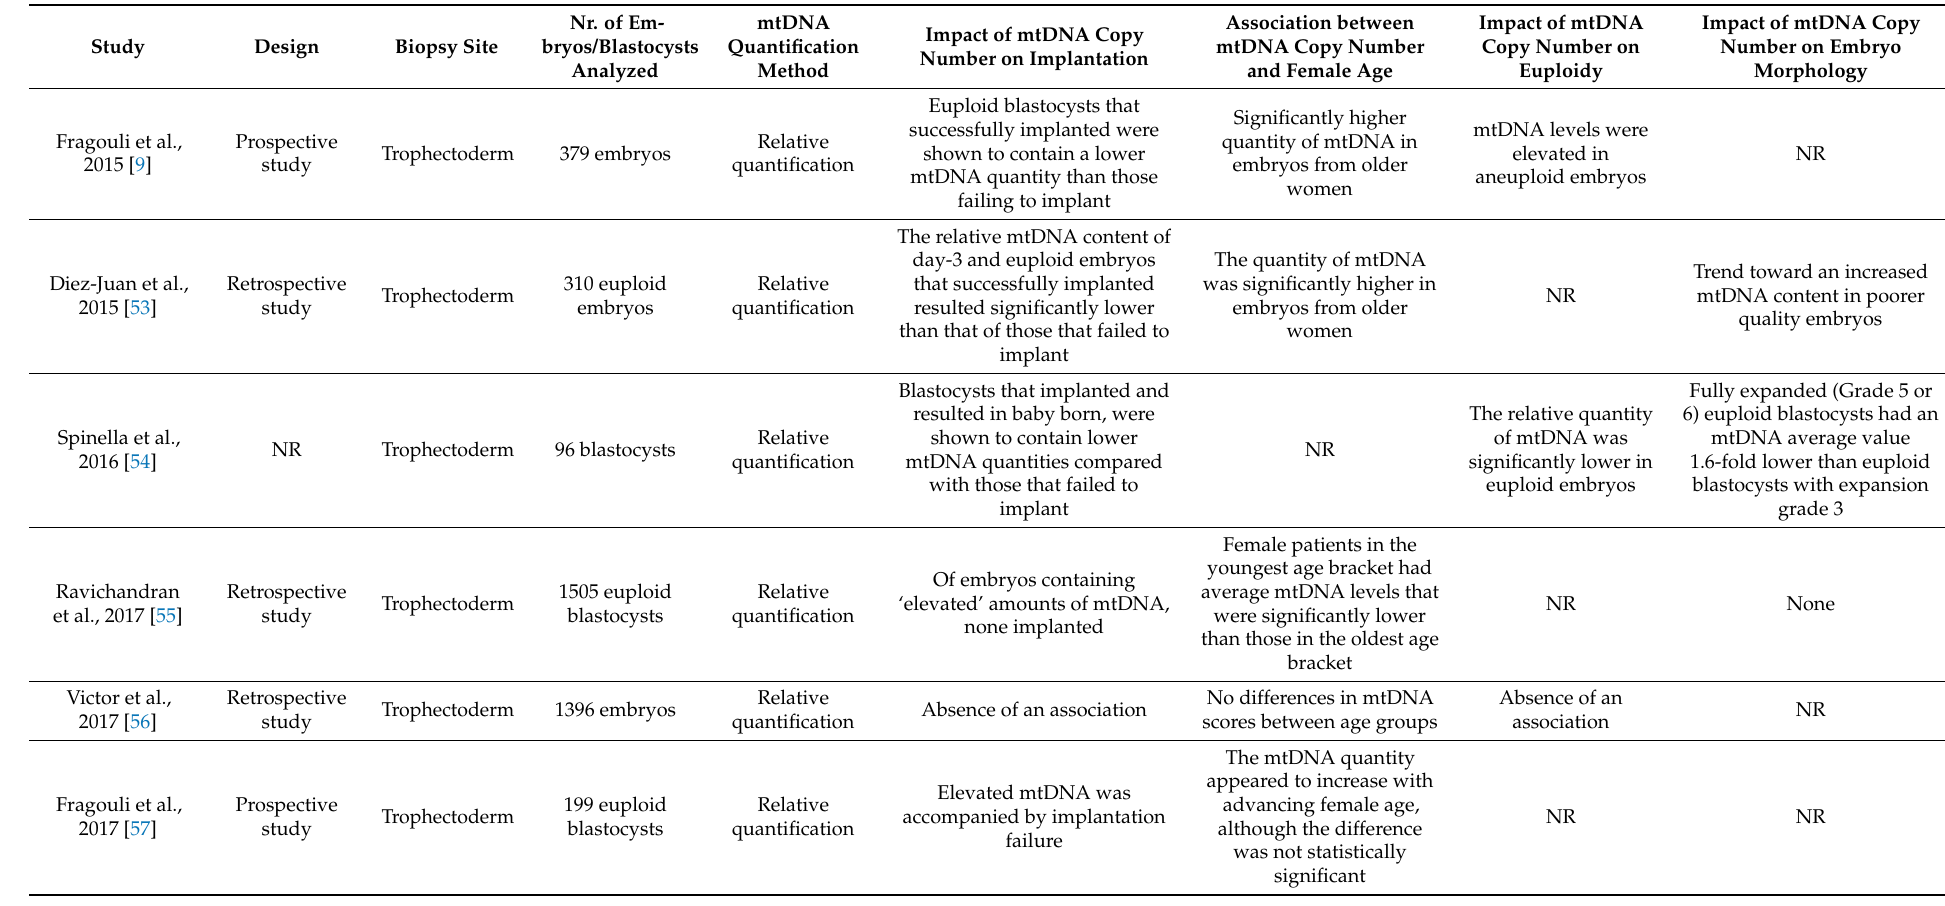
Table 1. Characteristics of studies investigating the association between mtDNA embryonic cells content and fertility